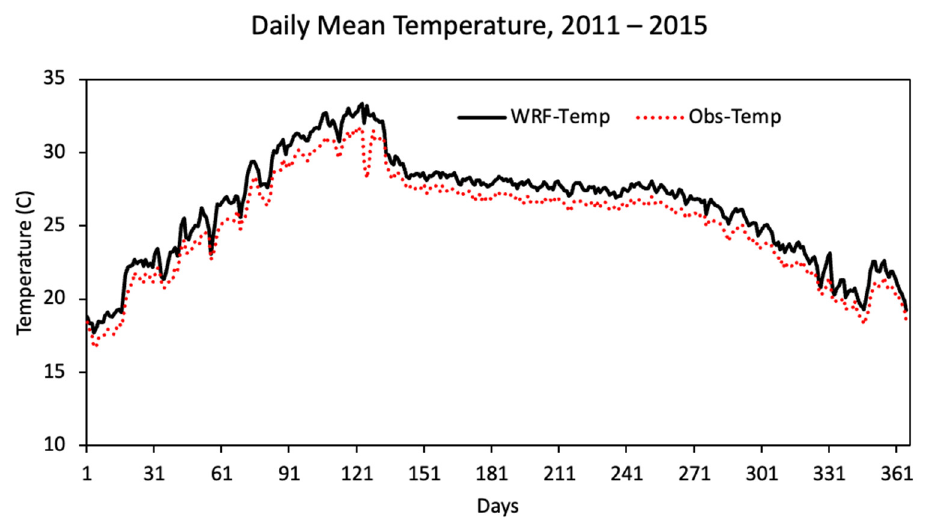
Figure 4. Daily mean temperature ( ◦ C) averaged over 2011–2015 based on 5 station locations of the Thai Meteorological Department (TMD) model (red dot) and the WRF model (black line).